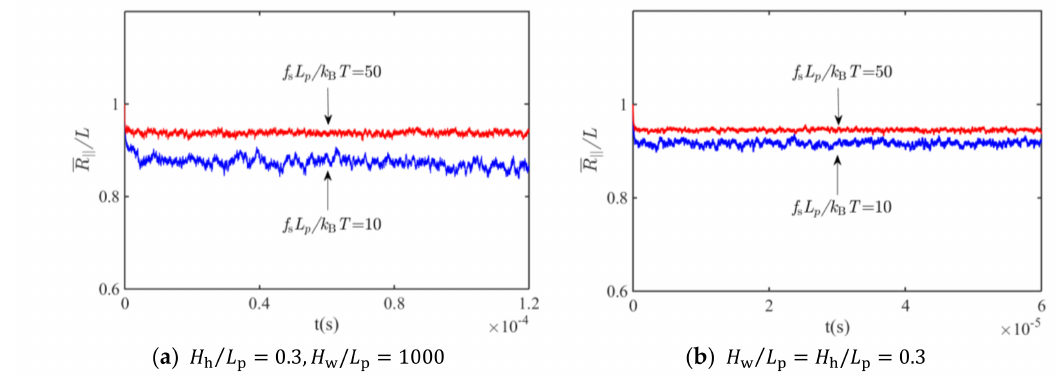
Figure 3. Evolution of the extension for tube-confined WLCs under stretching: ( a ) Slit, H h / L p = 0.3, H w / L p = 1000; ( b ) Square tube, H w / L p = H h / L p = 0.3.